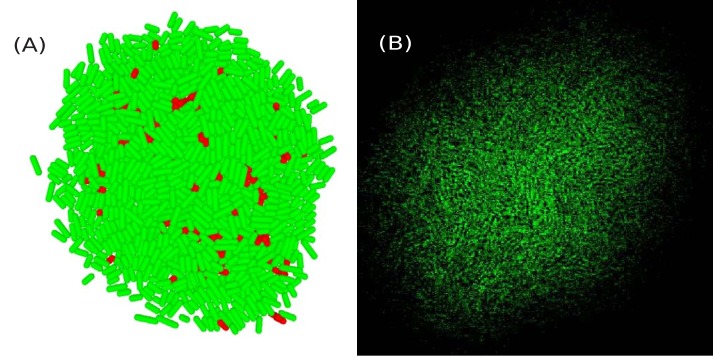
A few top layers of cells in the colony visualized using simulation data.(A) and experimental data (B). In (A), a cell is colored green (resp. red) if its angle with the vertical z-axis is less (resp. greater) than 45∘.